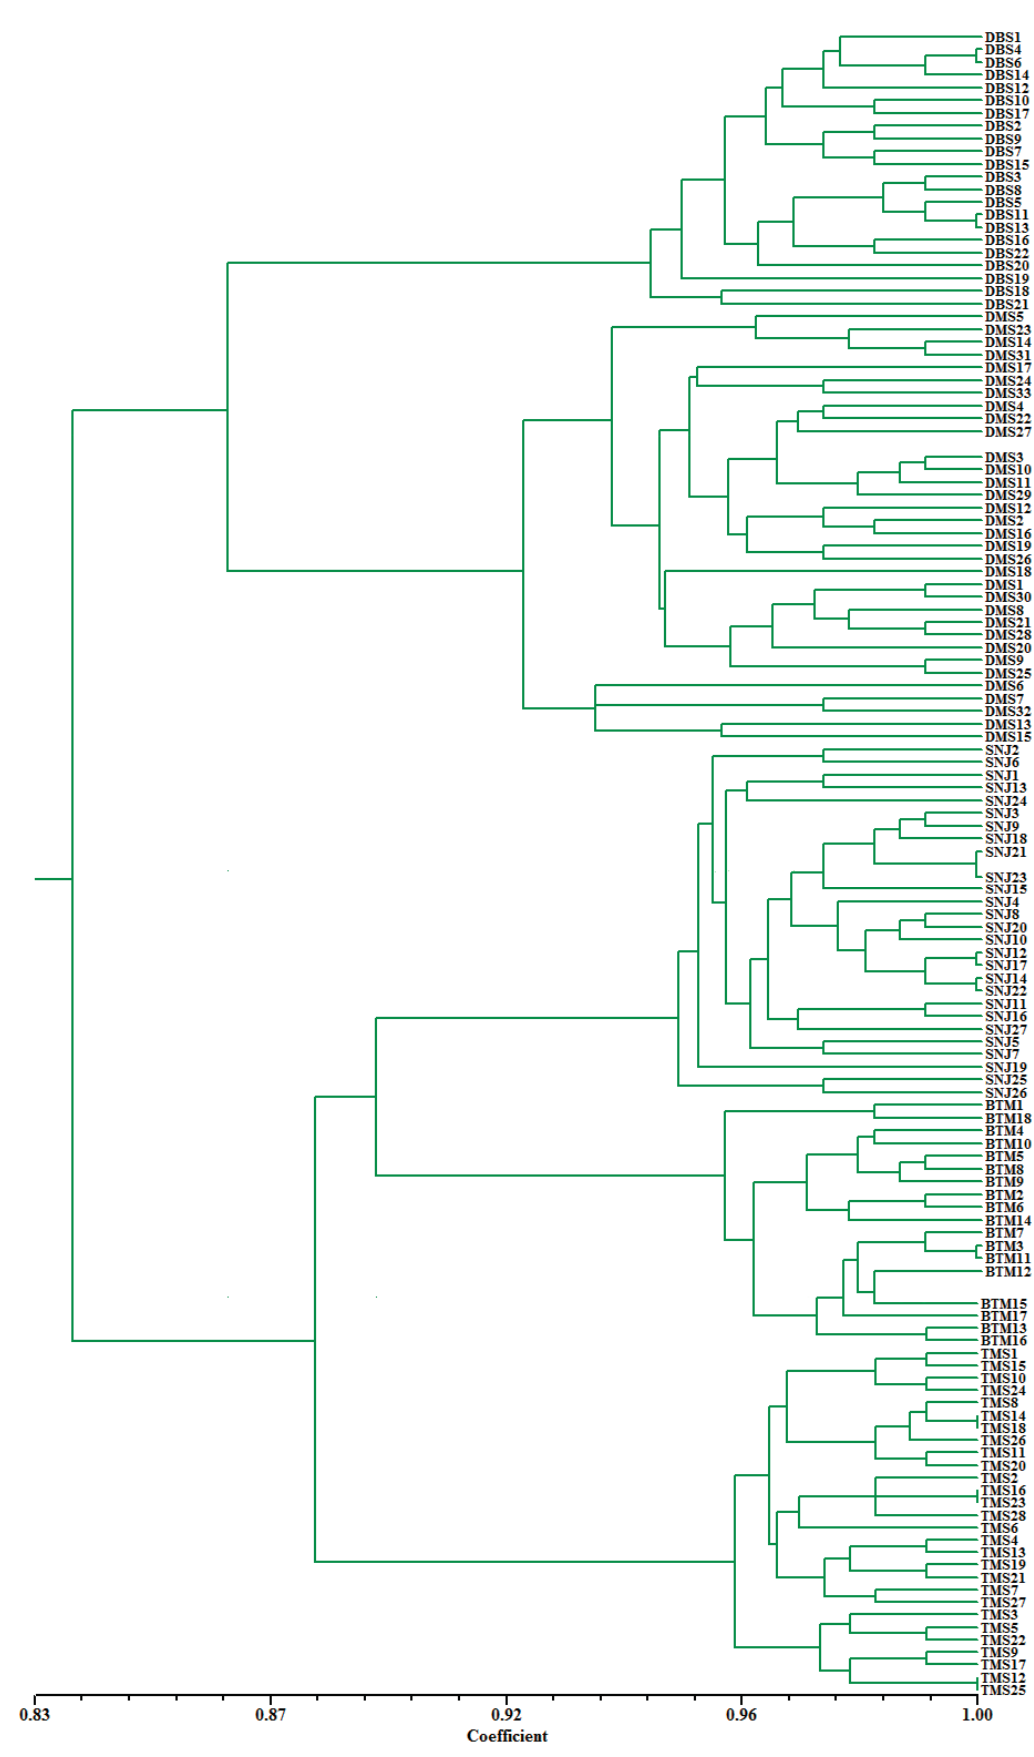
Figure 3. UPGMA dendrogram for all individuals of C. japonicum